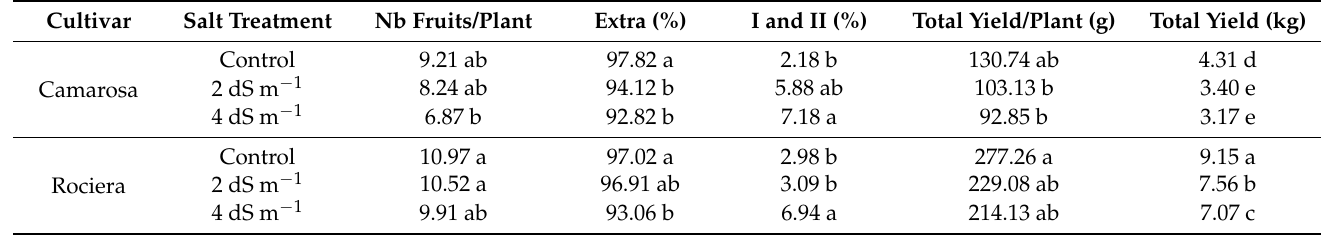
Table 4. Effect of salt stress on number of fruits per plant, classification of harvested fruits into categories (Extra, I and II), mean total yield per plant and mean total yield (thirty-three plants).